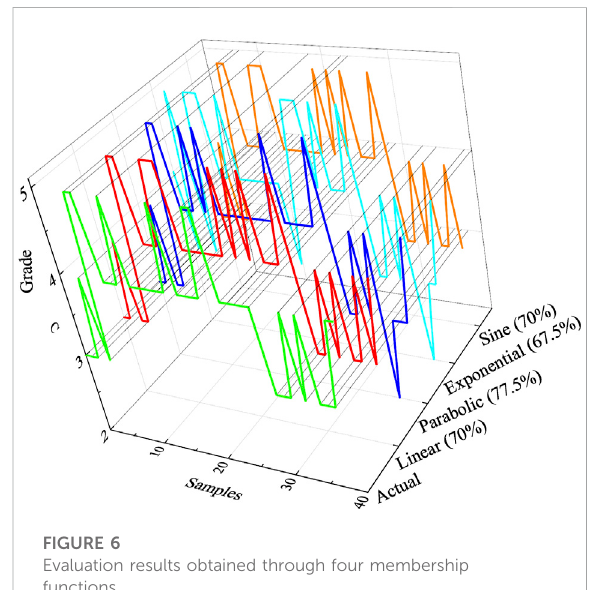
FIGURE 6 Evaluation results obtained through four membership functions.